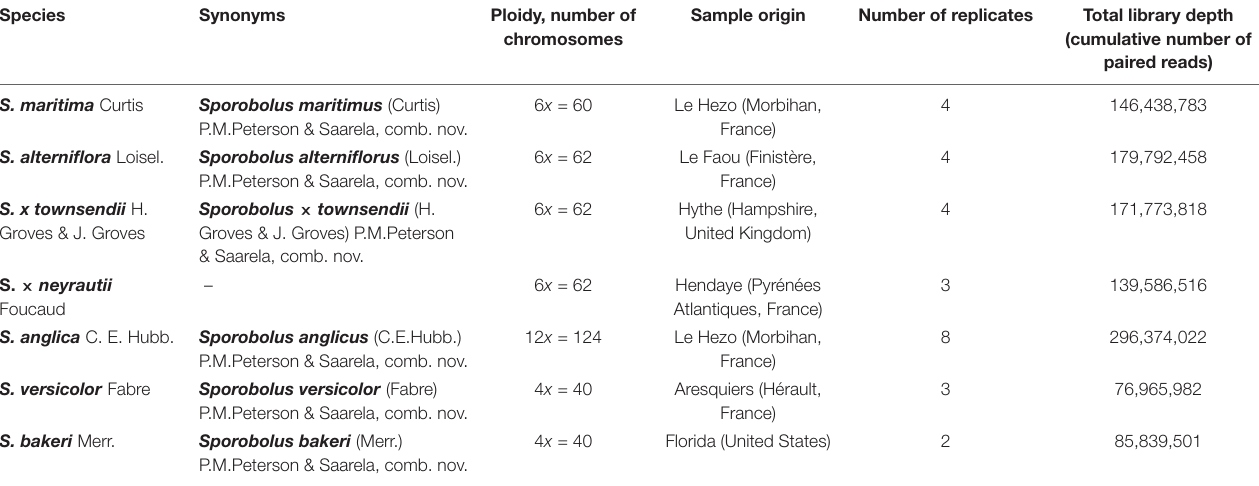
TABLE 1 | Studied polyploid Spartina species and summary of RNA-Seq Illumina datasets used.